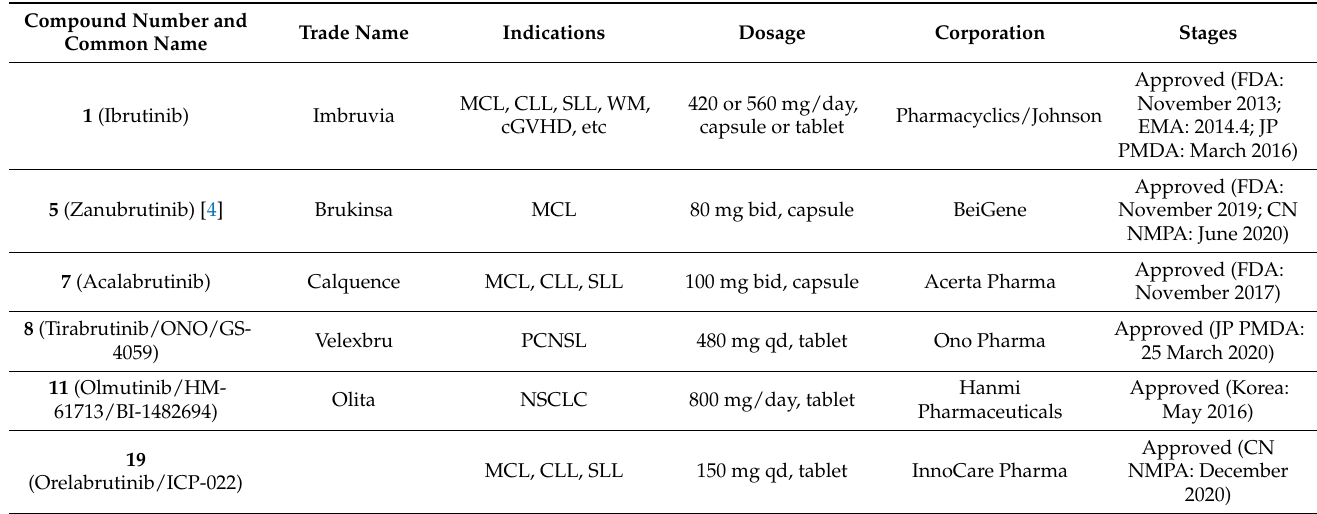
Table 1. The approved BTK inhibitors and their